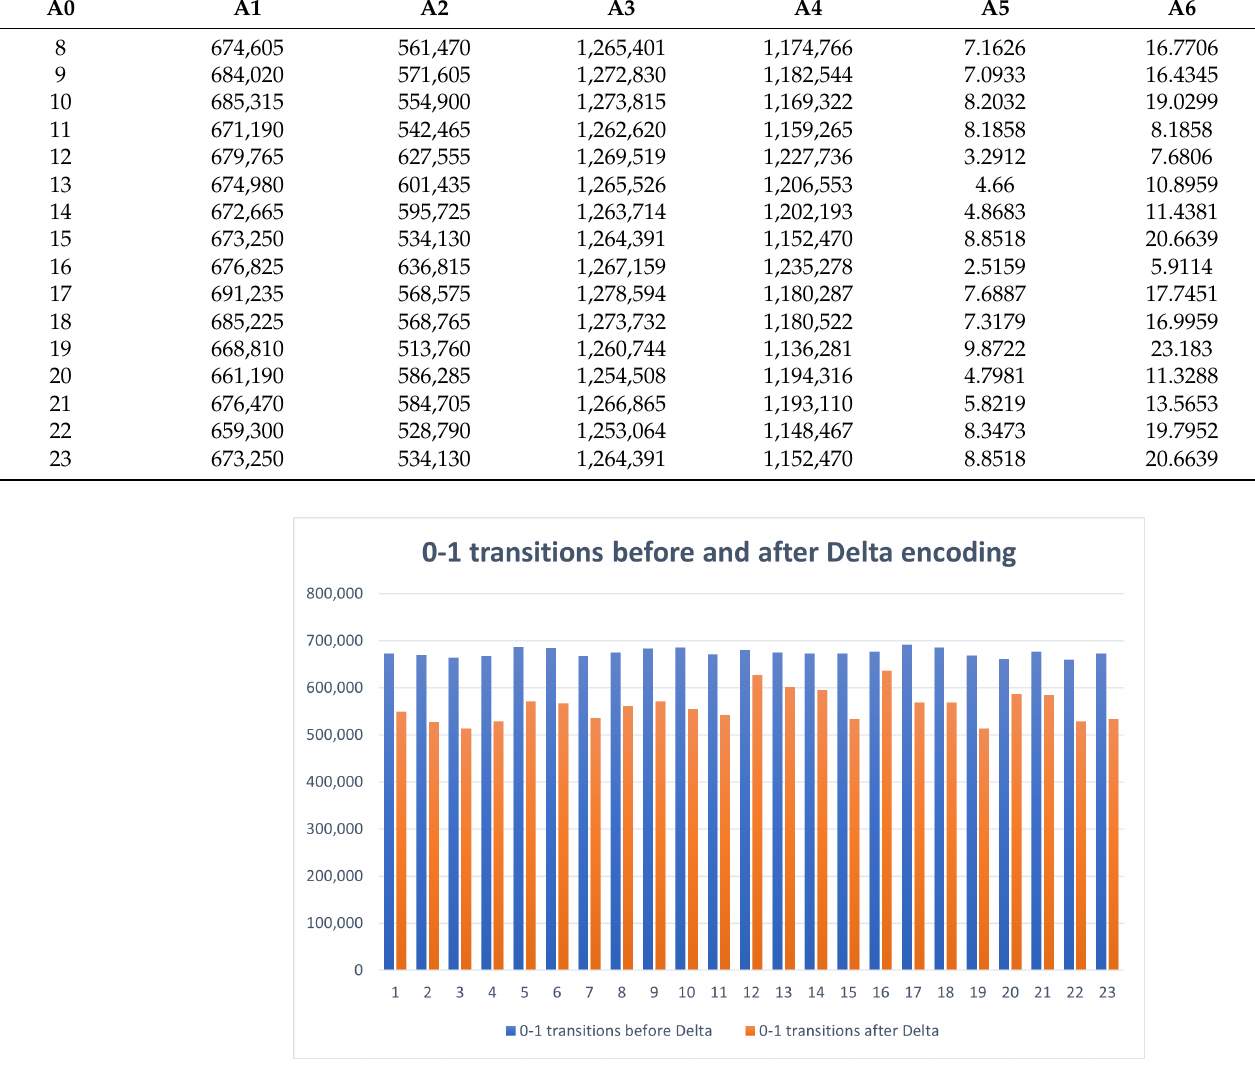
Figure 3. Bar chart of 0-1 transitions before and after Delta encoding for all the leads